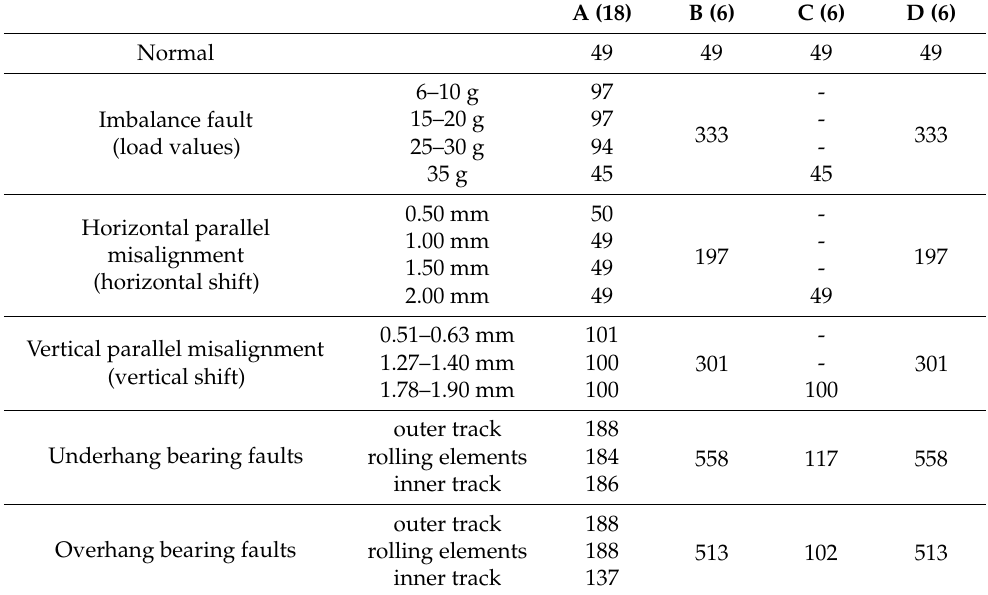
Table 1. The processed 4 datasets with fault type and number of